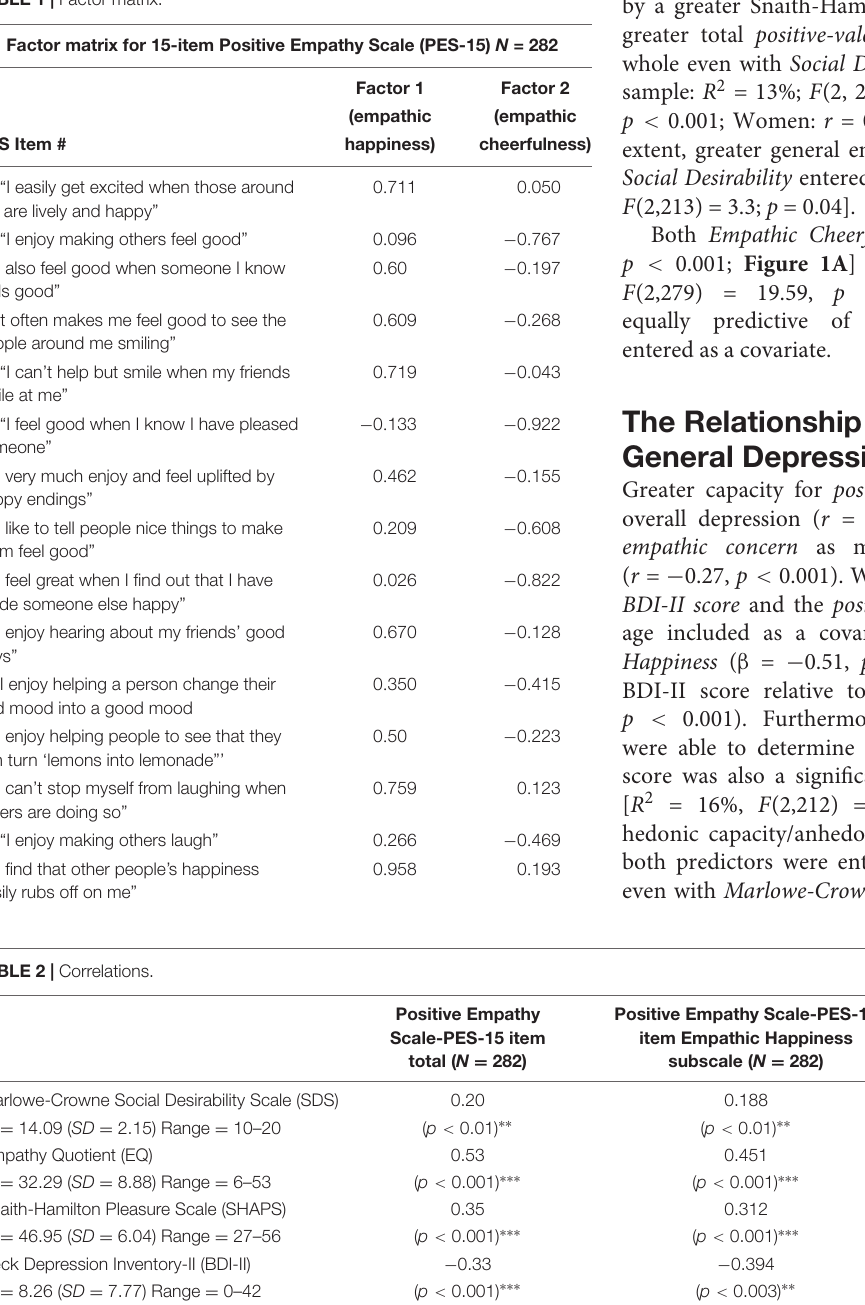
TABLE 1 | Factor matrix.